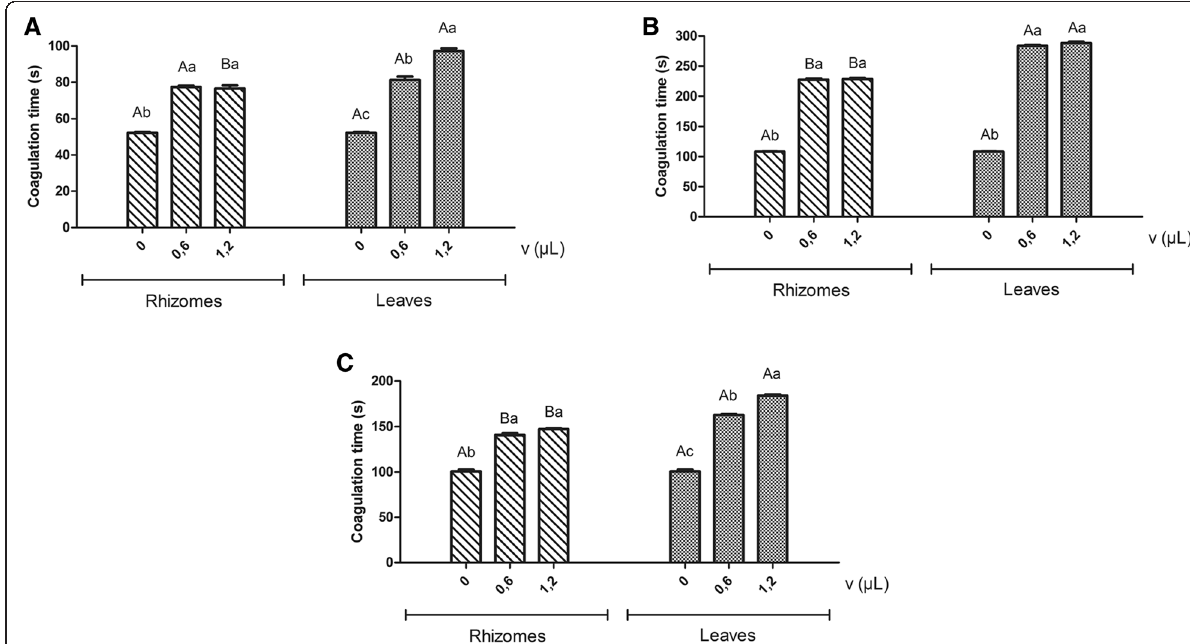
Figure 2 Effect of essential oils on the coagulation of the human plasma induced by Bothrops and Lachesis snake venoms after previous incubation of Lachesis muta, B. moojeni and B. atrox (50 μ g/mL) snake venoms at 37°C with different volumes of essential oils extracted from rhizomes and leaves of H. coronarium , followed by addition of citrated human plasma. (A) Lachesis muta inducing clotting. (B) Bothrops moojeni inducing clotting. (C) Bothrops atrox inducing clotting. Means followed by the same letter, in uppercase for comparison between the essential oils analyzed and in lowercase to compare volumes of the same essential oil, do not differ significantly at 5% probability by the Scott-Knott